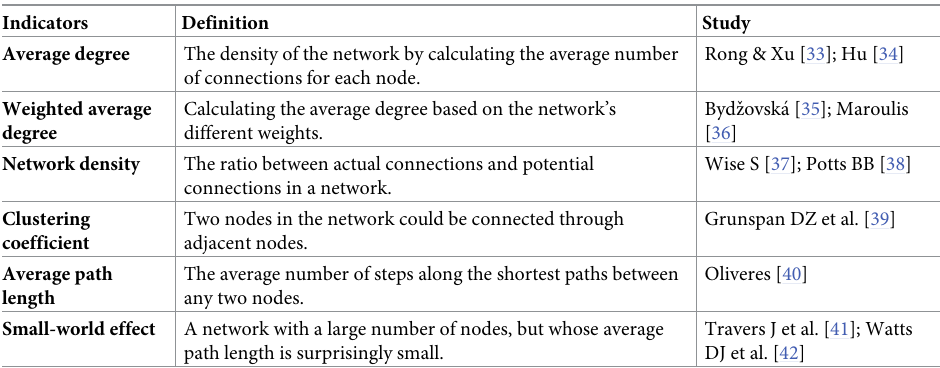
Table 3. Introduction of indicators for Question (2).